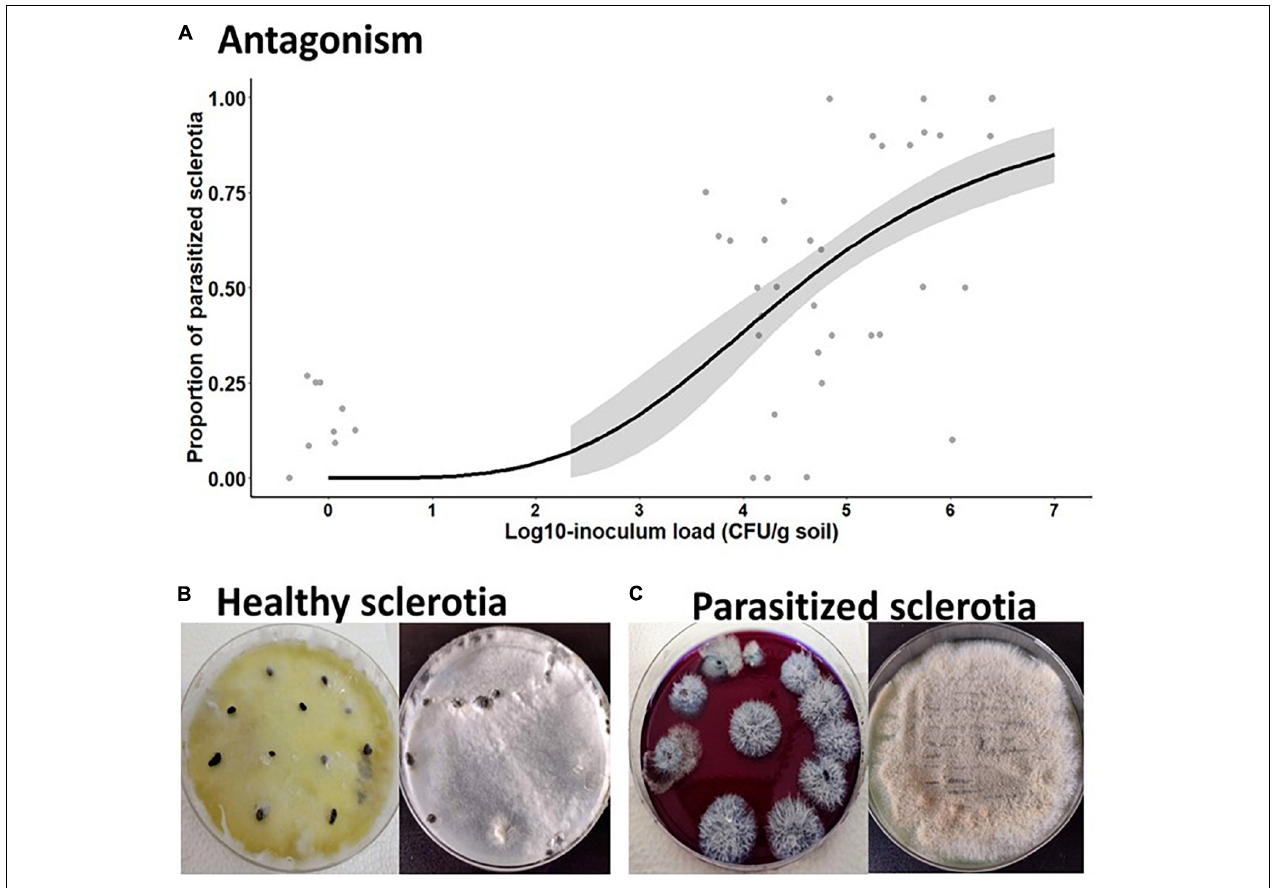
FIGURE 4 | Antagonism of C. rosea (strain CMAA1284) submerged conidia over sclerotia of S. sclerotiorum after soil treatment. (A) Relationship of parasitized sclerotia with inoculum load of C. rosea tested in sterile soil substrate. (B) Healthy non-parasitized sclerotia showing color change in the Neon medium to yellowish due to synthesis of oxalic acid and recovery of pure colony of S. sclerotiorum on PDA medium. (C) Parasitized sclerotia showing no color change in the Neon medium, indicating they were not viable, as they showed outgrowth of C. rosea confirmed by plating the fungus on PDA.